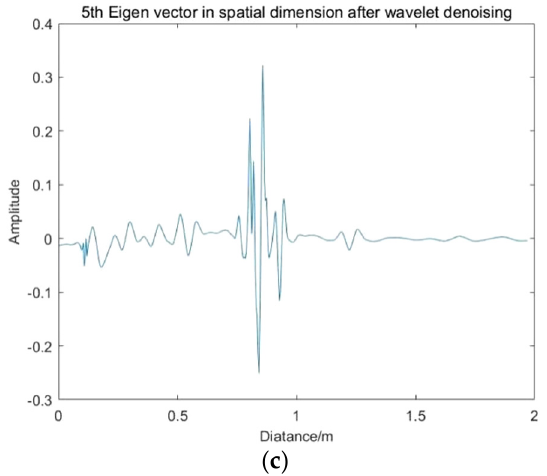
Figure 15. Spatial eigenvectors after wavelet denoising: ( a ) First spatial eigenvector after wavelet